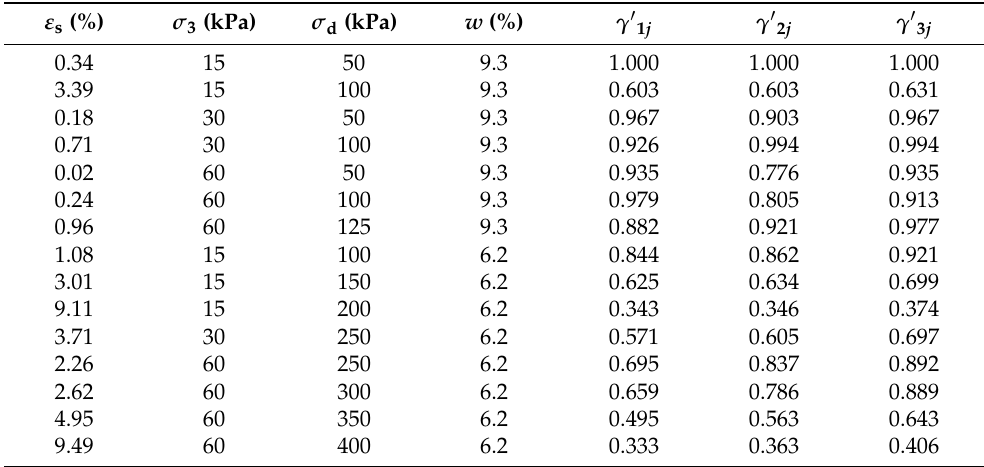
Table 4. Grey correlation coefficients of ε s with respect to w , σ 3 , and σ d .